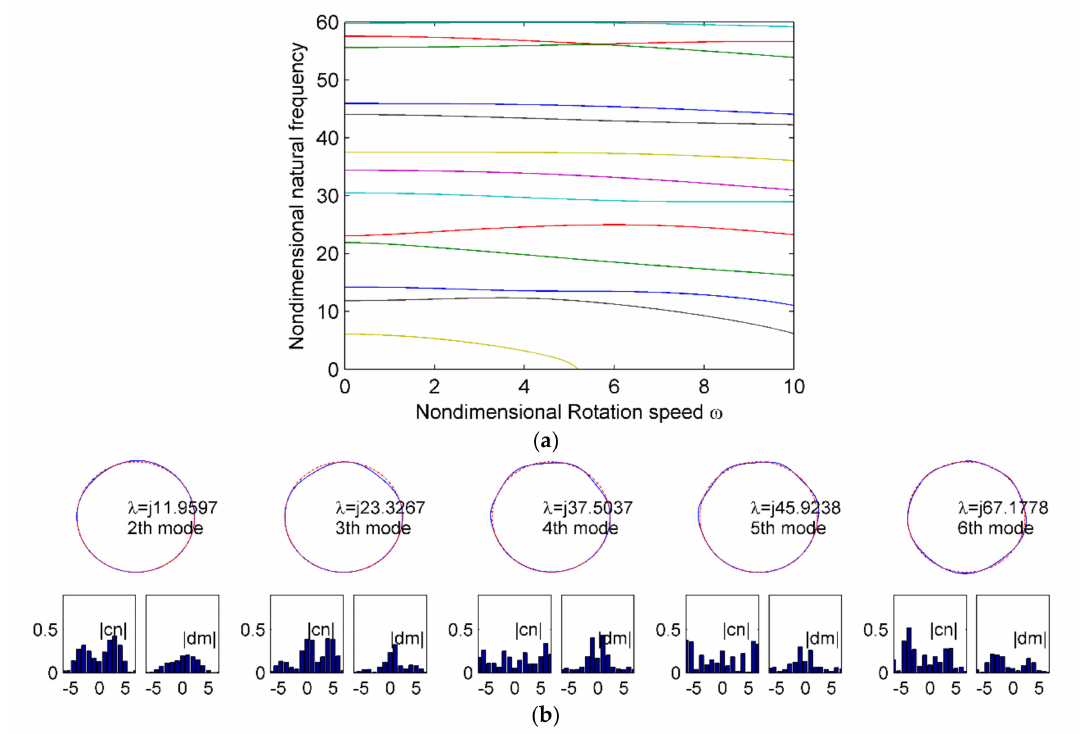
Figure 5. Natural frequencies and vibration modes of a planet ring with discrete and partial distributed stiffnesses ( N f = 20): ( a ) natural frequencies vs. rotation speed ω ; ( b ) typical vibration modes of planet rings at ω = 1 (dash line = original position; solid line = vibration mode).